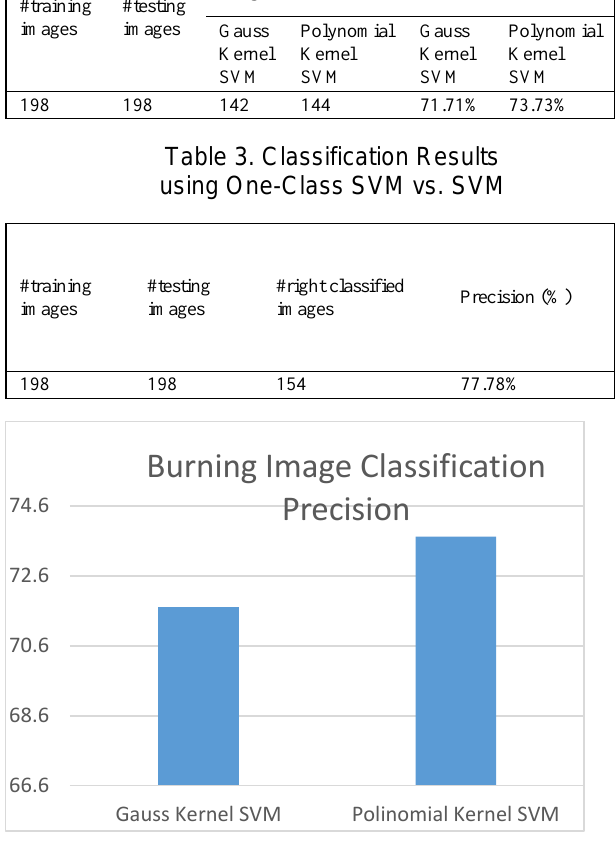
Fig. 19. Burning Image Classification Results using kernel- based SVM